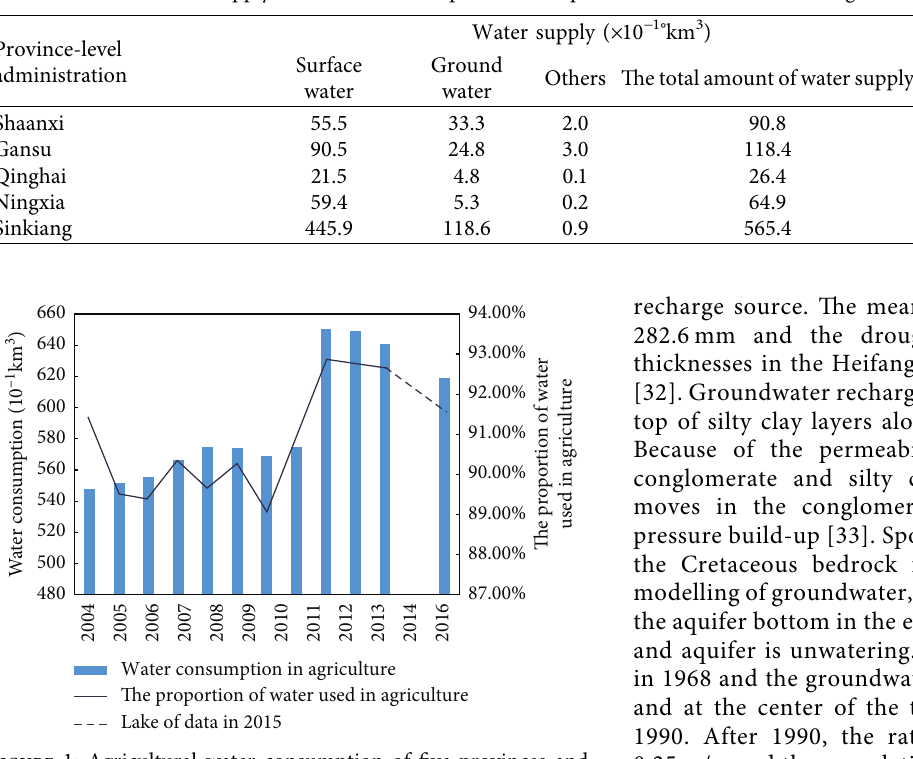
Figure 1: Agricultural water consumption of five provinces and autonomous regions in northwest China during 2004 to 2016 (China Water Resources Bulletin,